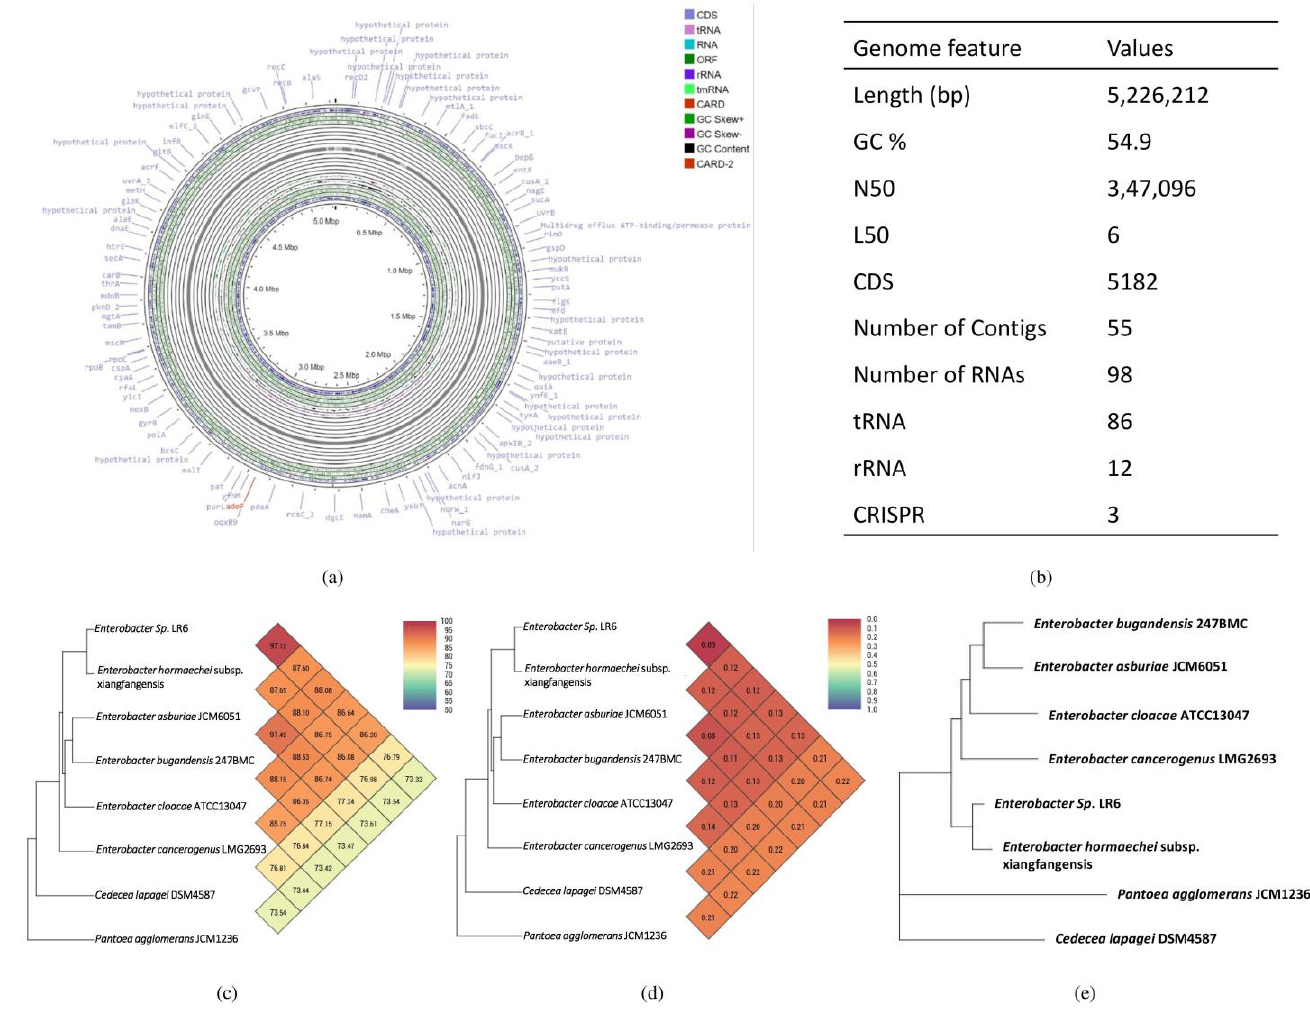
Figure 2. Graphical circular map of Enterobacter sp. LR6 . The green color and gray color represent the open reading frame and contigs, respectively. The outer circle in orange and blue color shows predicted antibiotic resistance and protein-coding sequences ( a ), the table showing its general genome feature ( b ), heat map and phylogenetic tree based on ( c ) ANI, ( d ) GGDC distance, and ( e ) whole- genome sequence of Enterobacter sp. with its closely related